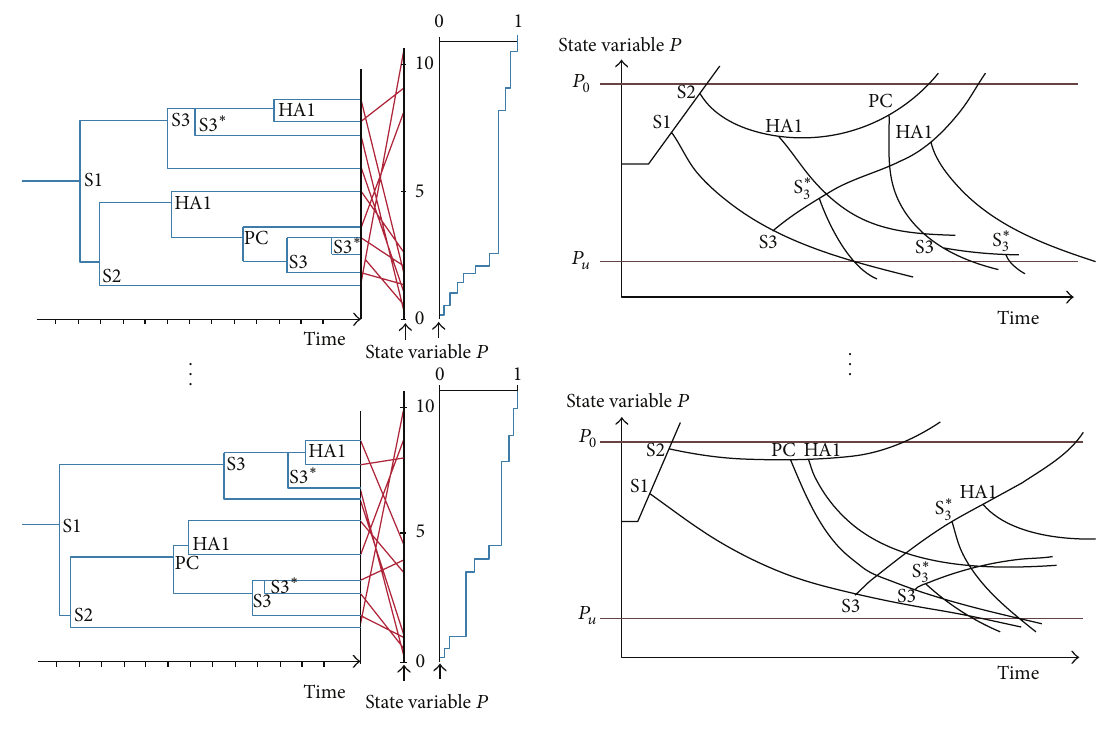
Figure 1: Sample of DETs represented in the time-event space (a) and in the time-state space (b).